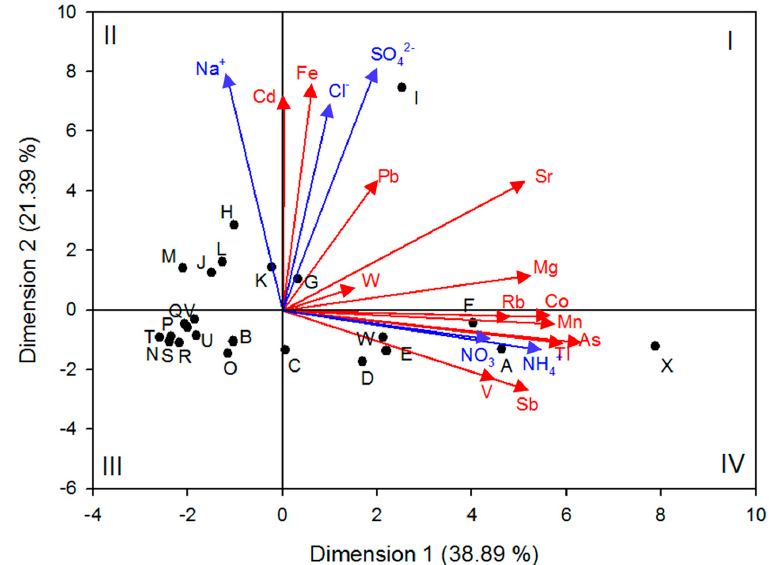
Figure 4. Bi-plot resulting from the PCA (PCA4) and detailing: In circles, the scores of the samples presented in this work (black with labels); the loadings of the six experimental variables Cl − , NO 3 − , SO 42 − , Na + and NH 4+ (blue vectors); the loadings of trace metals (red vectors); (I, II, III and IV indicate, respectively, 1st, 2nd, 3rd and 4th quadrants of the Cartesian space.); (PCA is performed using µg L − 1 unit concentrations and automatic normalization of the data).